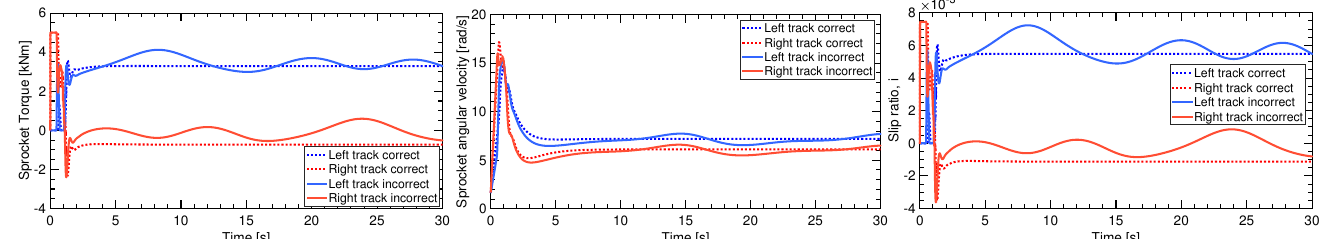
Figure 23. Trajectory following test (circular path) in case of incorrect knowledge of resistance coefficients: torque behavior ( left ), sprocket rotational velocity ( middle ), and slip of the track ( right ).